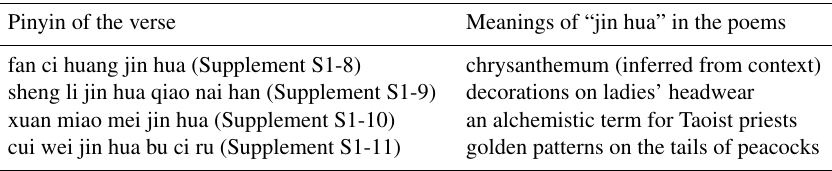
Table 3. Different meanings of the Chinese phrase “jin hua” in poems of the Tang Dynasty. Pinyin of the verse